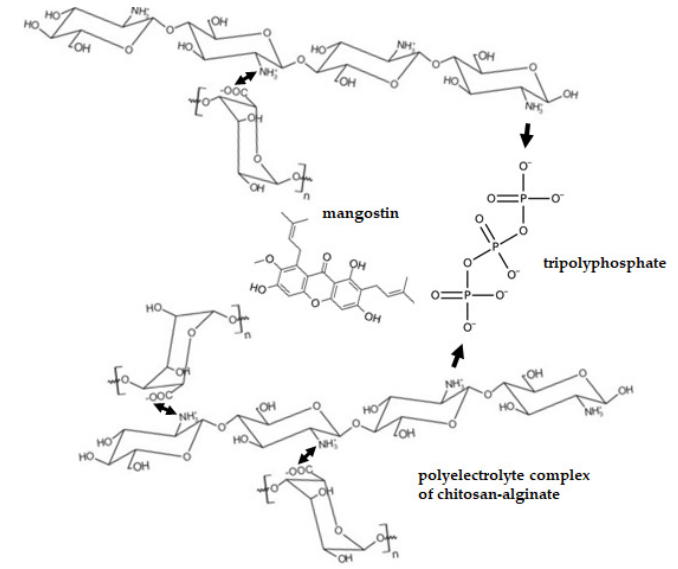
Figure 4. Illustration of the ionically crosslinked chitosan–tripolyphosphate gel (single arrow) and chitosan–alginate polyelectrolyte complex (double arrow) in the chitosan–alginate microparticles.